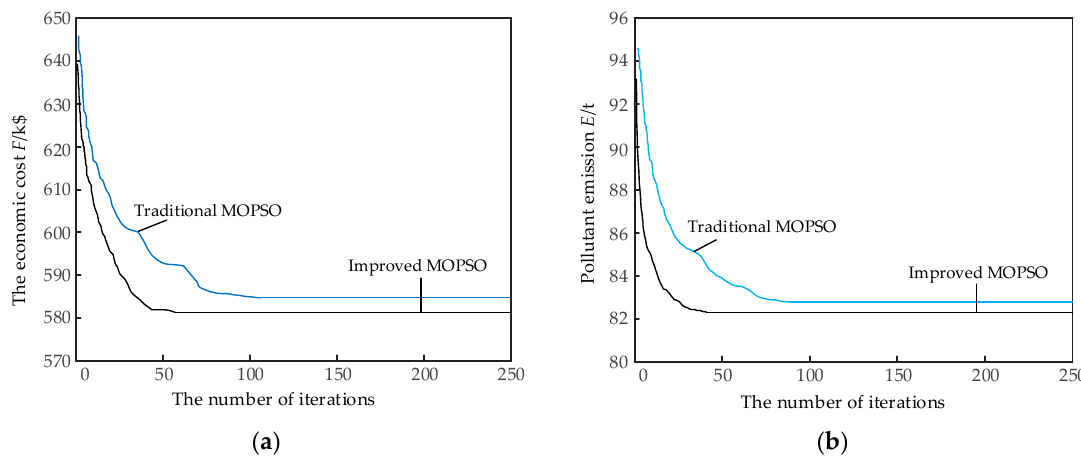
Figure 10. ( a ) Comparison of convergency among different algorithms. ( b ) Comparison of convergency among different algorithms.